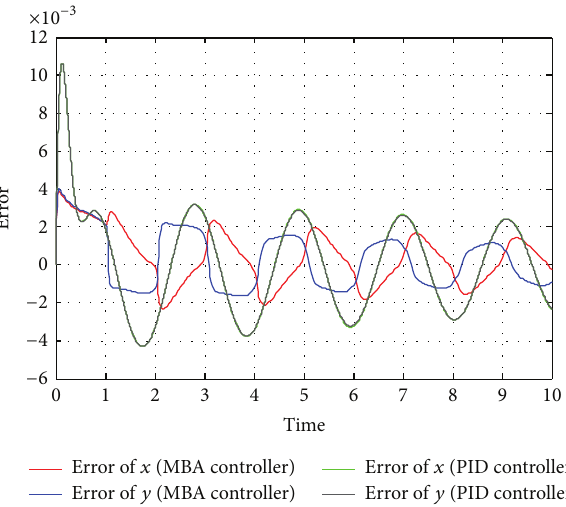
Figure 9: Position error of quadrotor in linear flight.